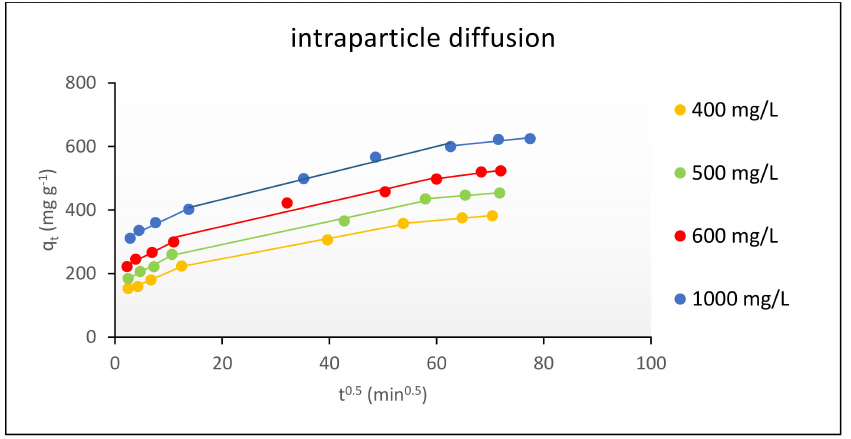
Figure 13. The intraparticle diffusion plots for adsorption of CR dye onto UCs using different initial